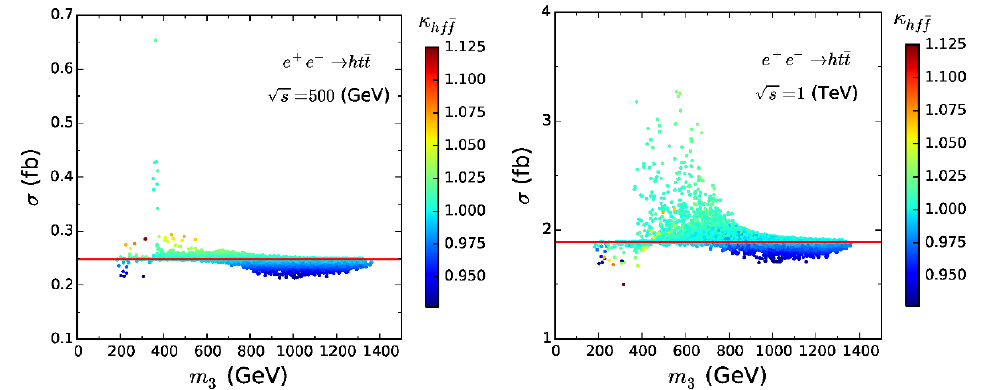
p mass m 3 at s = 500 GeV (left) 3